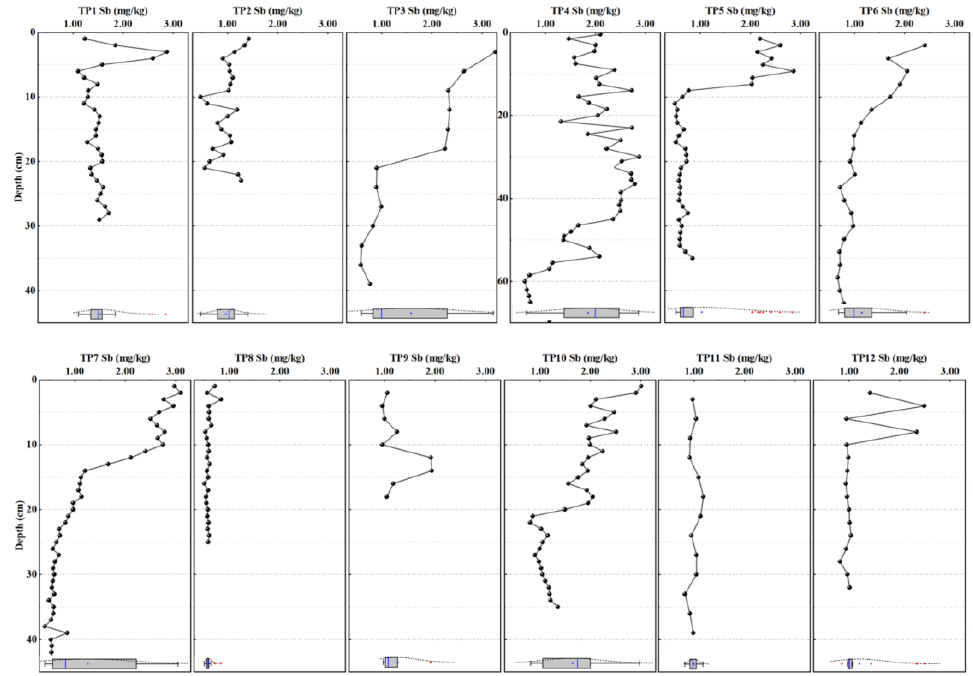
Figure 2. The vertical distribution of Sb in sediment cores sampled in the Taipu River (concentration of Sb (mg/kg): TP1: 1.10—2.87, TP2: 0.46—1.42, TP3: 0.59—3.27, TP4: 0.59—2.88, TP5: 0.50—2.86, TP6: 0.67—2.41, TP7: 0.41—3.10, TP8: 0.51—0.84, TP9: 0.95—1.94, TP10: 0.81—3.01, TP11: 0.82—1.18, TP12: 0.83—2.49).